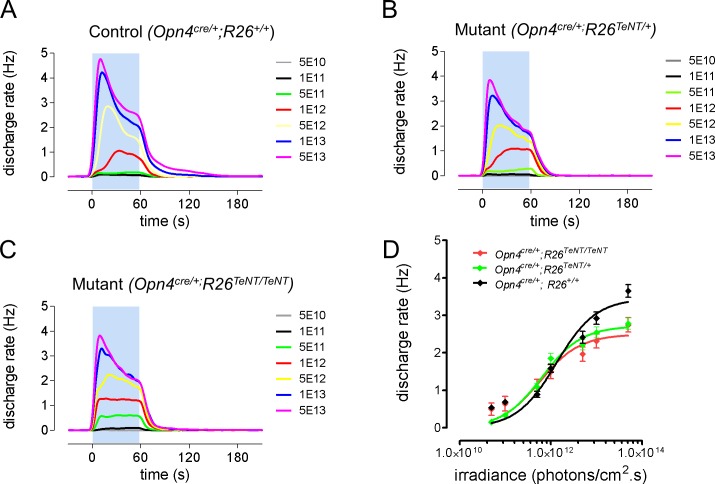
TeNT expression doesn’t alter ipRGCs responses to light.(A-C) Average ipRGCs responses to 1min light stimulations (480nm) of increasing irradiance (5.1010 photons/cm2/s to 5.1013 photons/cm2/s) recorded from retinas of Opn4cre/+, R26+/+ (A, n = 123), Opn4cre/+, R26+/TeNT (B, n = 87), Opn4cre/+, R26TeNT/TeNT (C, n = 158) mice and the corresponding dose response curves (D).